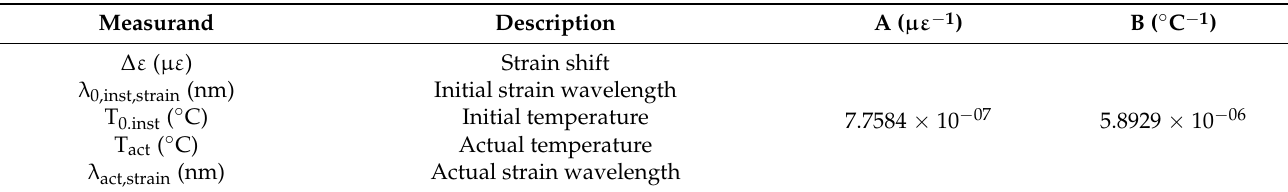
Table 2. The strain of the optical fibre sensor is the function by the optical FBG-800 interrogator enabling dynamic measurements A and